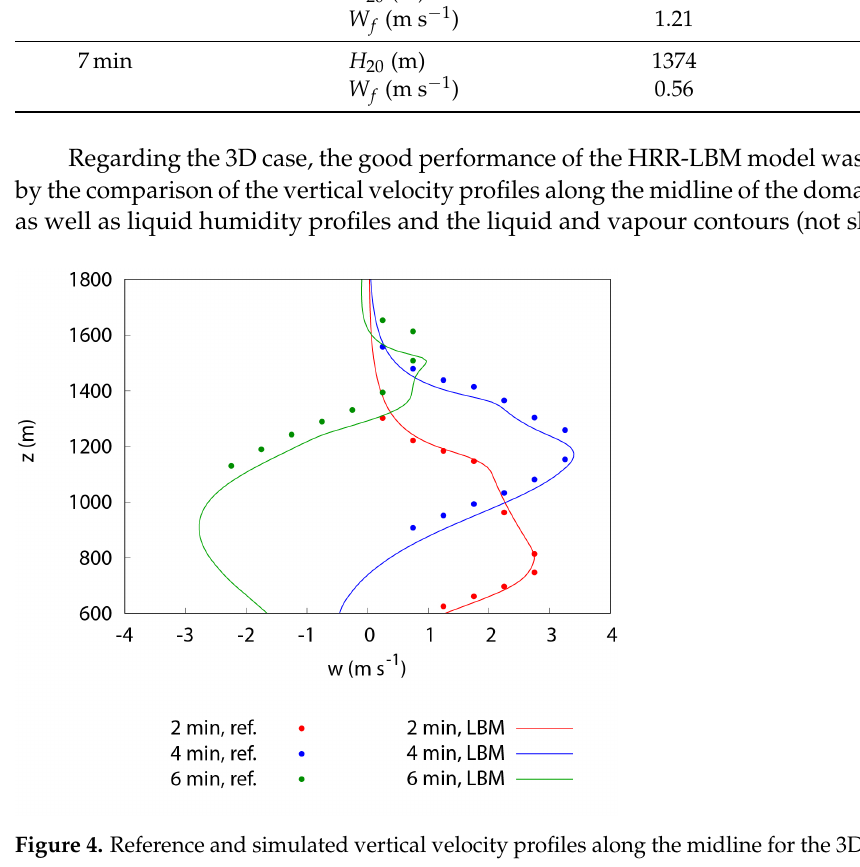
Figure 4. Reference and simulated vertical velocity profiles along the midline for the 3D moist bubble at 3 different times.